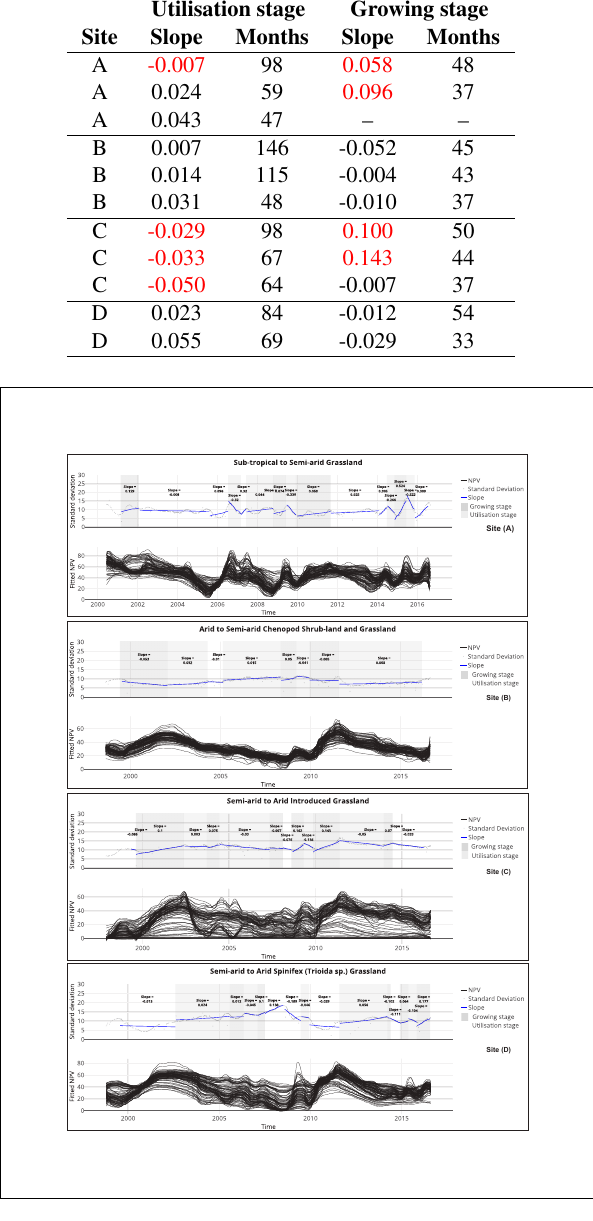
Figure 14. Confluence and divergence plots of the four example grasslands. The top plot of each site details (1) each generalised growth and utilisation stage highlighted in shades of grey, (2) the time-series of the standard deviation between each NPV time-series and (3) the slope and trend, annotated and indicated by the blue line, of the standard deviation for each stage. The bottom plot of each site details the individual subset fitted NPV